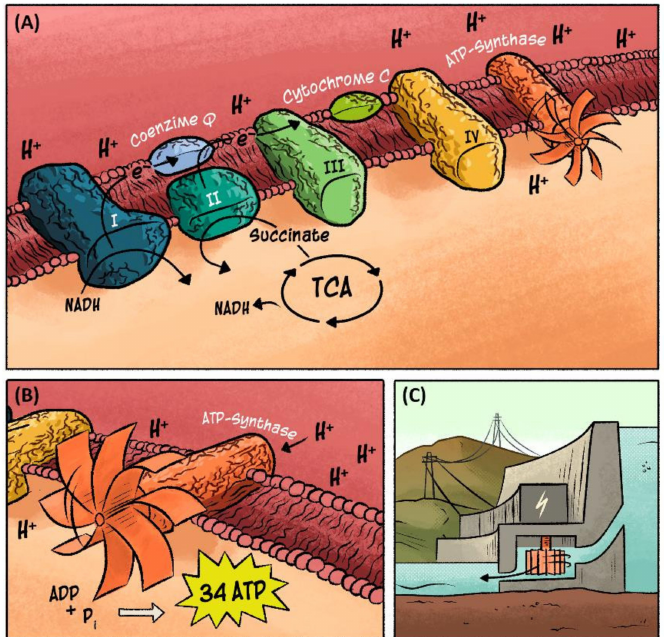
Figure 1. Typical representation of the electron transport chain in the inner mitochondrial membrane and the generation of an electrochemical gradient ( A ). The use of the gradient to synthesize ATP by the ATP synthase can be depicted as a system of rotating paddles based on structural information ( B ). More metaphorical is an analogy to show how a hydroelectric dam produced electricity ( C ).